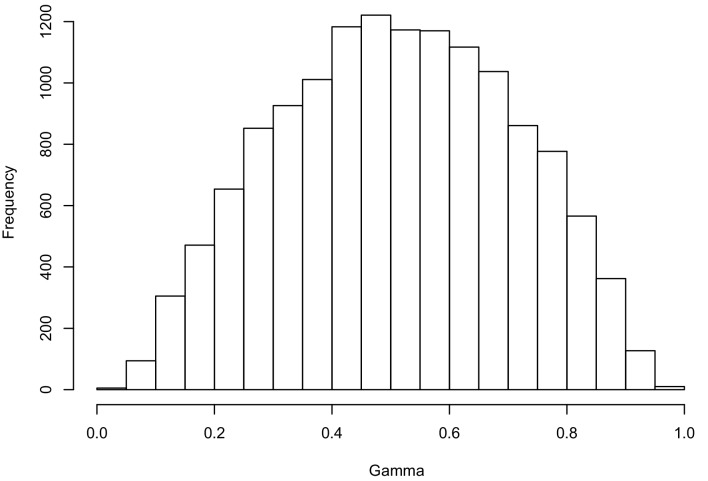
Hybridization levels among the 48 Erysimum species estimated by HyDe.The histogram shows the gamma score (hybridization proportion) distribution in all the significant detections (13,922 out of 51,888 tests after Bonferroni correction). Scores of 0.3 to 0.7 indicate high levels of hybridization.